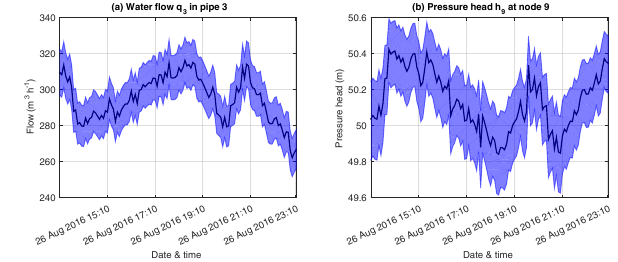
Figure 3. State estimate (black line) and bounds on this estimate using the IHISE algorithm (blue area) for the water flow in pipe 3 (a) and the head at node 9 (b) .